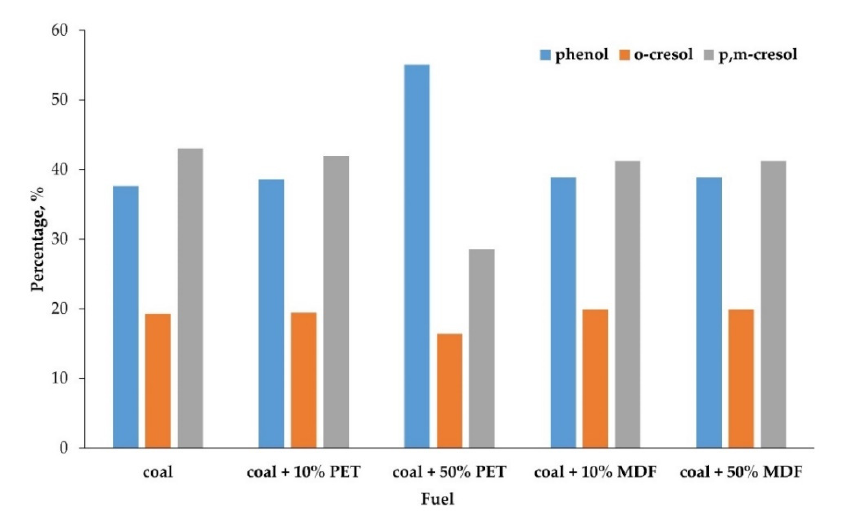
Figure 3. Percentage of individual phenols in total emission of phenols.